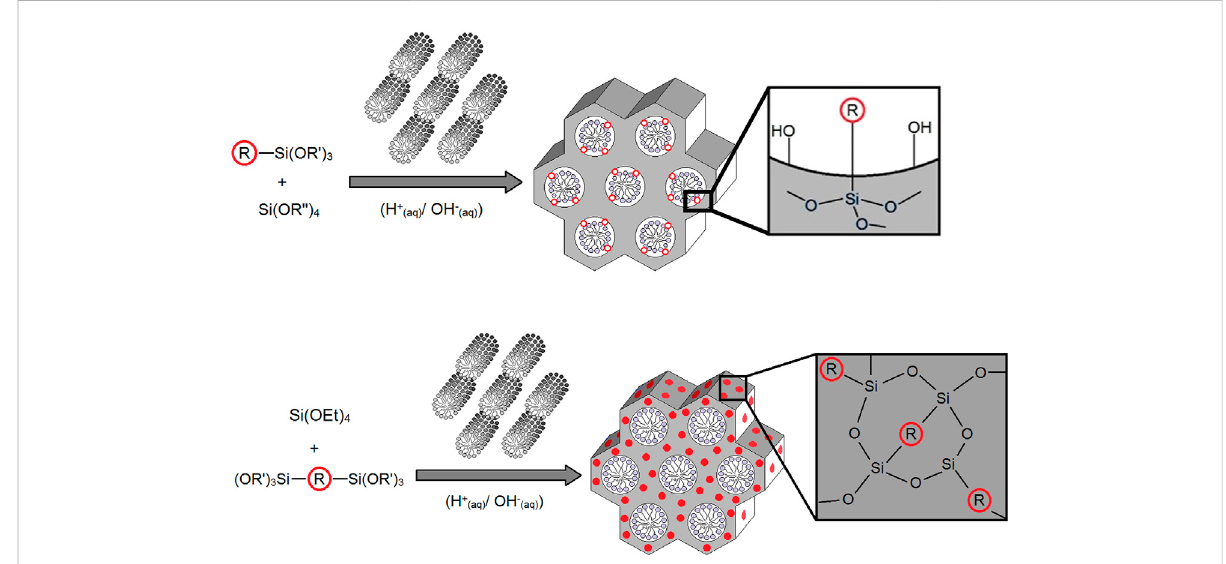
FIGURE 3 General synthetic route for the PMOs made using BOPHY1 (top) and BOPHY2 (bottom), where R = BOPHY core structure.